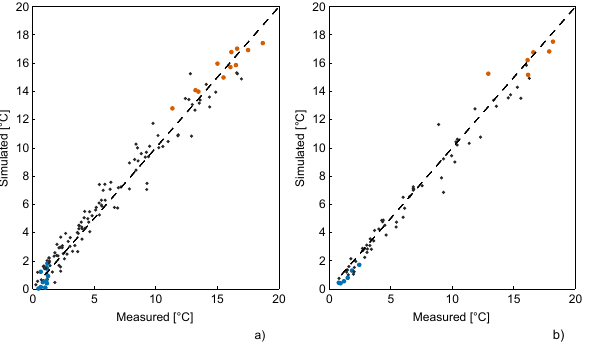
Fig. 11. Parity diagram for monthly averaged surface water tem- Fig.11. Paritydiagramformonthly-averagedsurfacewatertemperature(8-parametersversionofthemodel):a)calibrationandb)validation periodoftheGLERLsimulation.BluedotsrefertoMarch,reddotstoAugustandgreydotstotheremainingmonthsoftheyear. perature (eight-parameter version of the model): (a) calibration and (b) validation period of the GLERL simulation. Blue dots refer to March, red dots to August and gray dots to the remaining months of the year.